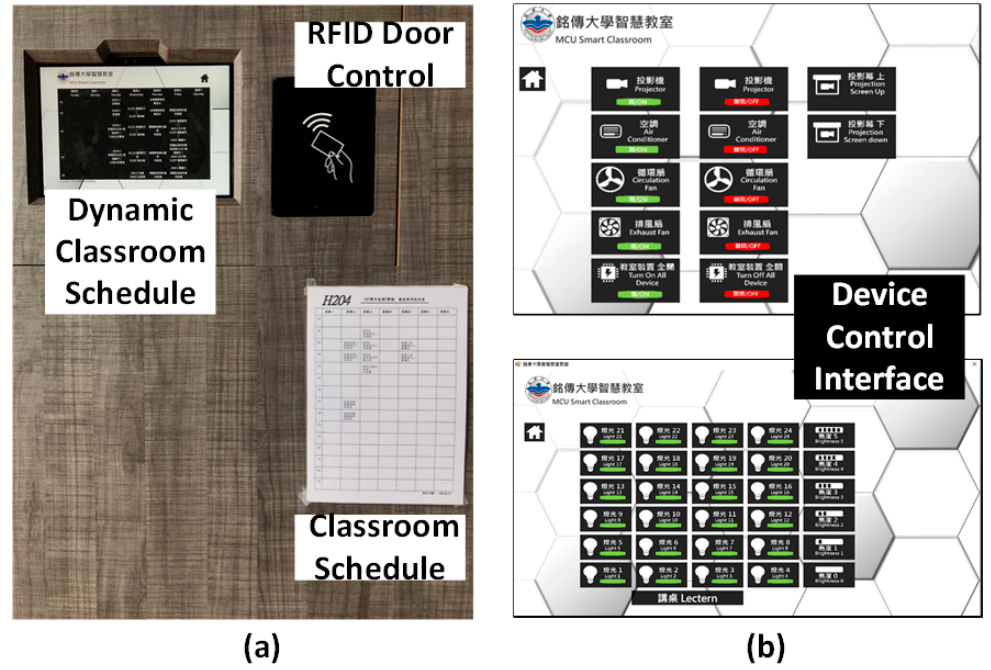
Figure 4. Device control: ( a ) an RFID-based door access system and an information board next to the front door. Dynamic classroom schedule‘s information is up to date while the paper schedule’s information is outdated; ( b ) Device control user interface on teacher’s computer to control fans, air conditioners, and lights.